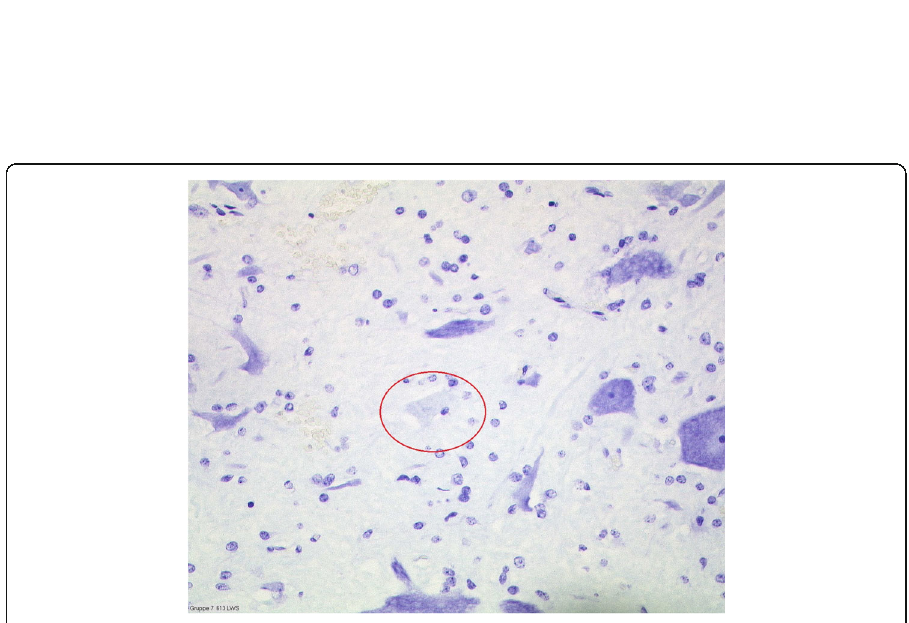
Fig. 3 Histology of the spinal cord of familial hypercholesterolemia Bretoncelles Meishan (FMB) pig. Nissl staining of an ischemic infarction in the gray matter of an FBM pig on atherogenic diet after I/R injury. The red frame marks a necrotic